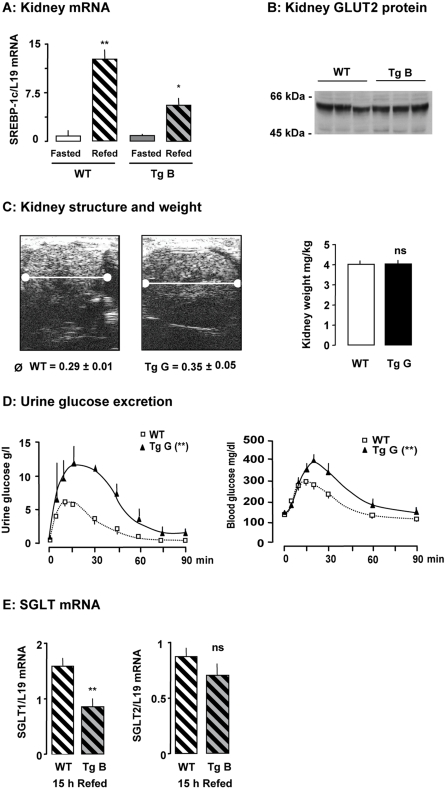
Kidney function in mice after impairment of extracellular sugar detection.A: Effect of a glucose-rich diet on gene expression in the kidney of transgenic (Tg) and wild-type (WT) mice fasted for 48 h and refed for 15 h. Levels of mRNA were analyzed by real-time PCR. Values are presented as means±S.E.M. (n = 3 to 4 mice/group). Statistical differences between refed and fasted mice are indicated as *P<0.05, **P<0.01 and ns non significant. B: GLUT2 protein levels in total membrane preparations of kidney from mice fed with a glucose-rich diet for five days. C: Structure, size and weight of kidneys from wild-type and transgenic mice shown by ultrasonic image (transverse cross section). D: Urine and blood glucose concentrations during an oral glucose tolerance test in fasted wild-type and transgenic mice (n = 3 mice per group). Statistical differences between transgenic and wild-type mice are indicated as **P<0.01 (two-way ANOVA) for the areas under the curves. E: Levels of SGLT mRNA were analyzed by real-time PCR. Values are presented as means±S.E.M. (n = 3 to 4 mice/group). Statistical differences between refed and fasted mice are indicated as **P<0.01 and ns non significant.